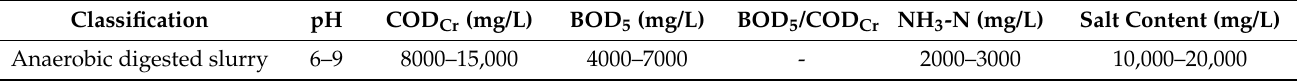
Table 4. Characteristics from anaerobic digested slurry in